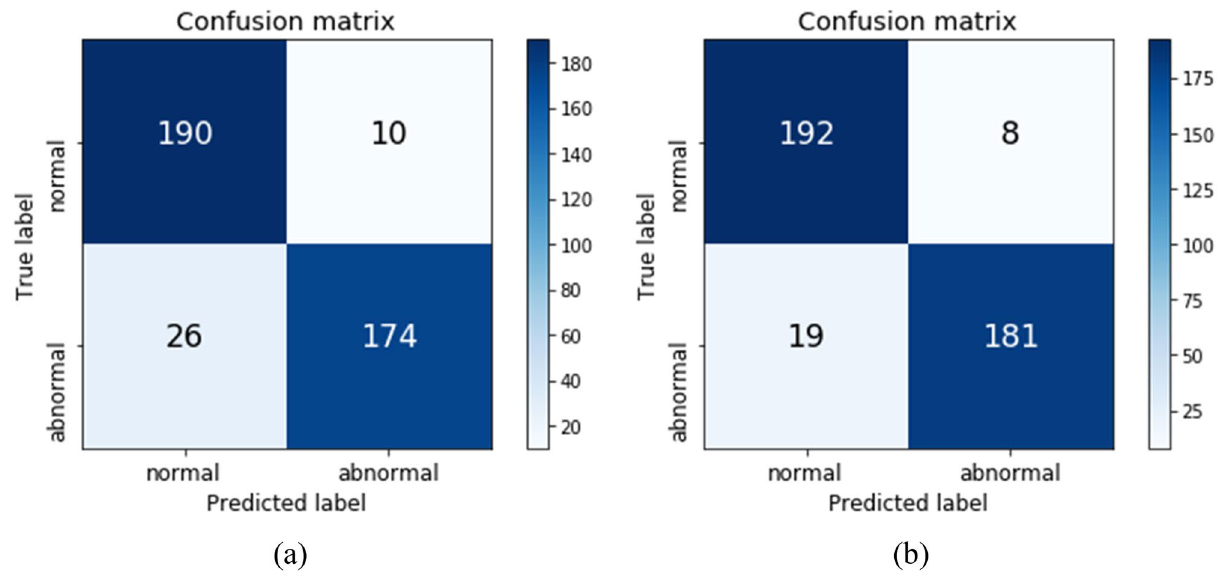
Figure 4. Confusion matrices of the two models. ( a ) Performance of the trained model using only the real dataset. ( b ) Performance of the trained model using the synthetic mixed